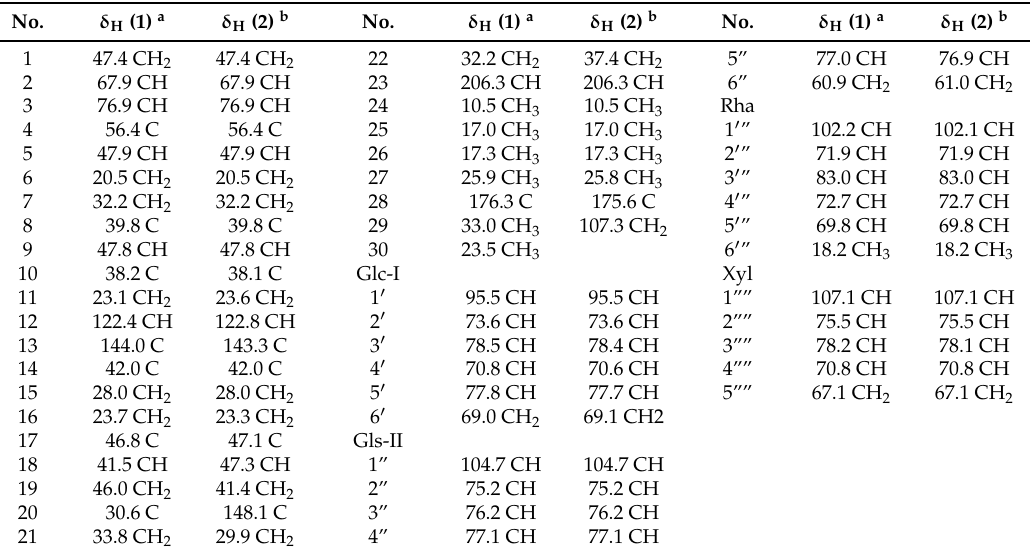
Table 2. The 13 C-NMR (150 MHz) spectral data ( δ (ppm)) of compounds 1 and 2 .